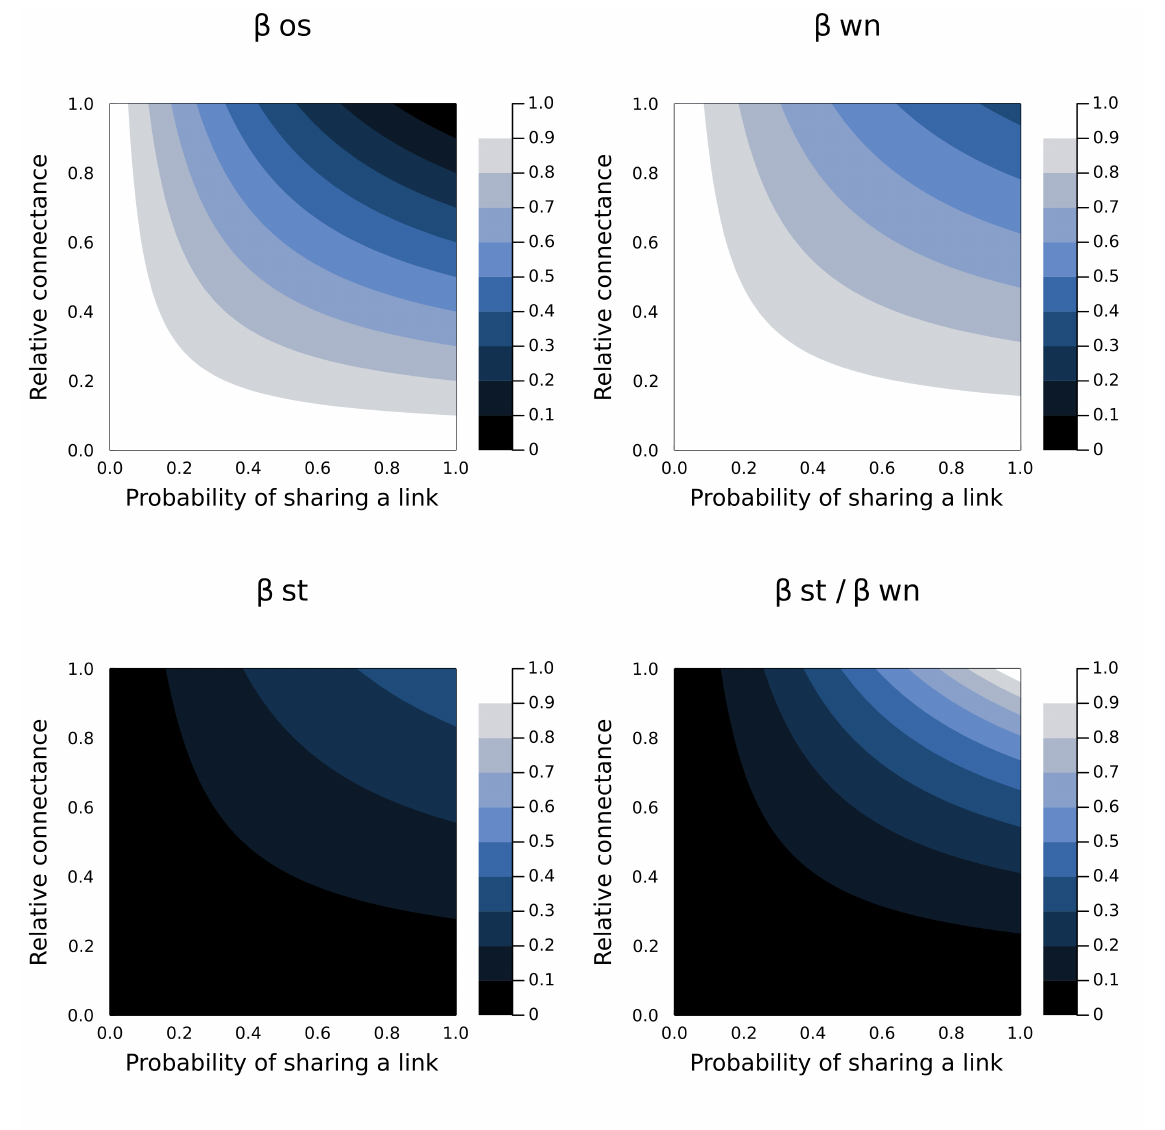
Figure 3 – Consequences of changing the ratio of connectances between two equally species-rich networks on the decomposition of network beta-diversity, assuming p = 0.8 . Networks with stronger differences in connectance will tend to be more similar, because the differences in number of links becomes extreme enough that the chances of all the links in the sparser network being in the denser network